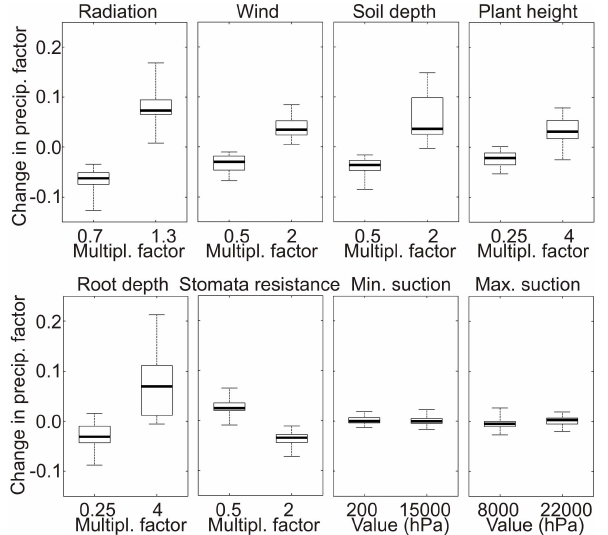
Fig. 12. Sensitivity analysis of the change in the calibrated precip- itation bias factor as a result of changes in inputs for the time pe- riod 1979–1984. The boxplots show summaries of the results aver- aged over the six subcatchments and seven precipitation data sets with the thick black line indicating the median, the boxplot area the interquartile range and the whiskers the minimum and maximum